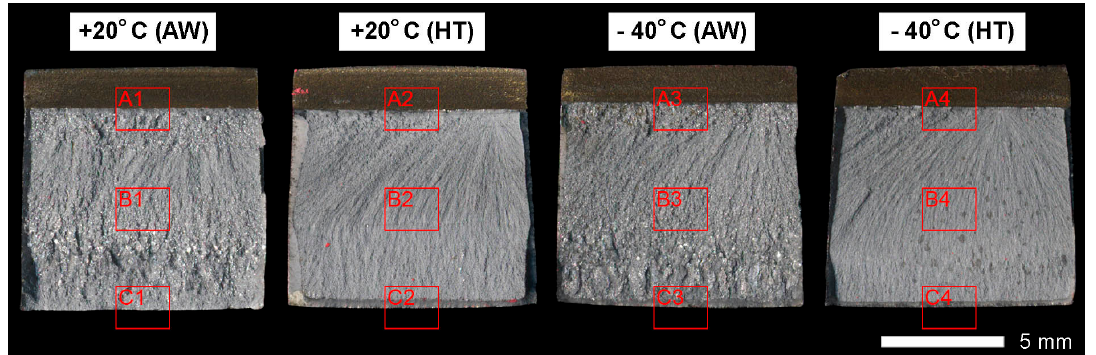
Figure 24. Macroscopic images of representative specimens of Hardox Extreme welded joints after impact testing. AW—condition after welding, HT—condition after heat treatment. Marked with frames: A—under-notch zone, B—central zone, C—final fracture zone. Stereoscopic microscopy, unetched.